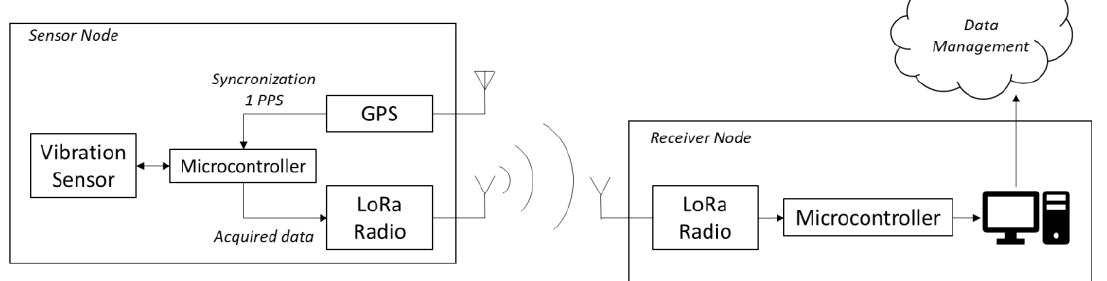
Figure 1. Block diagram depicting the architecture of the developed system.